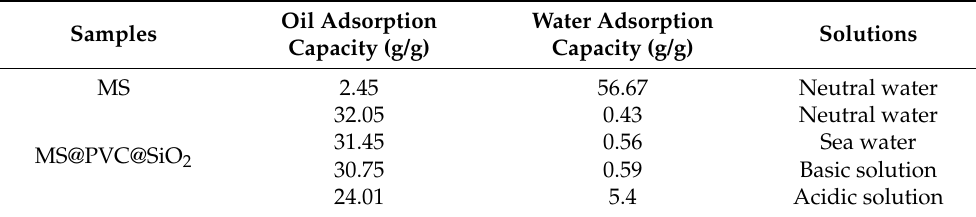
Table 2. The selective sorption capacity of oil and water by MS and MS@PVC@SiO 2 .